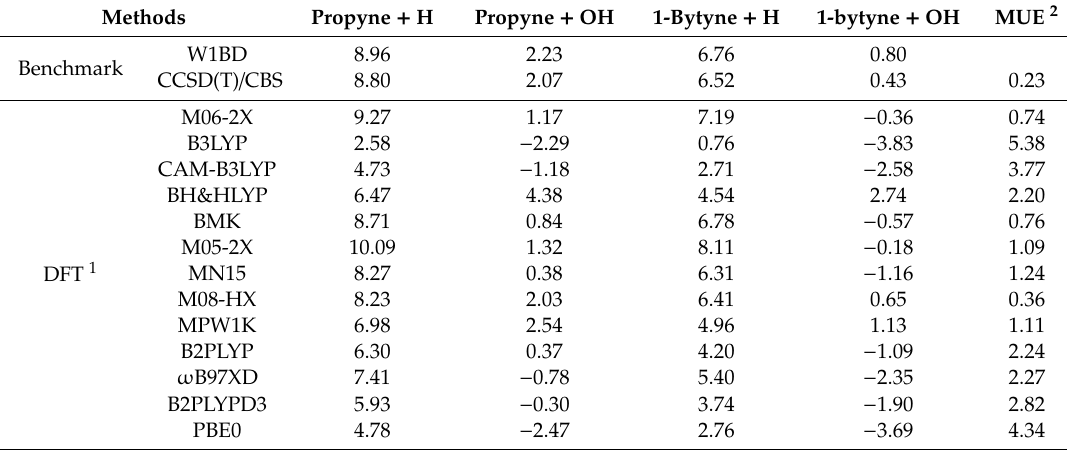
Table 1. The computed reaction barriers using di ff erent methods for H-abstraction reactions of propyne and 1-butyne by H and OH radicals (units: kcal mol − 1 ).